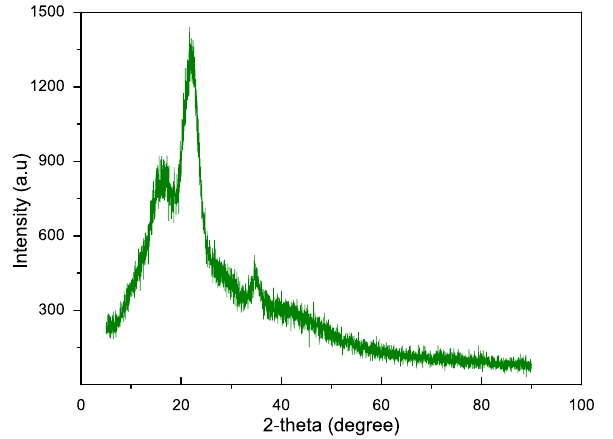
Figure 4. X-ray diffraction patterns of CTF fibers.